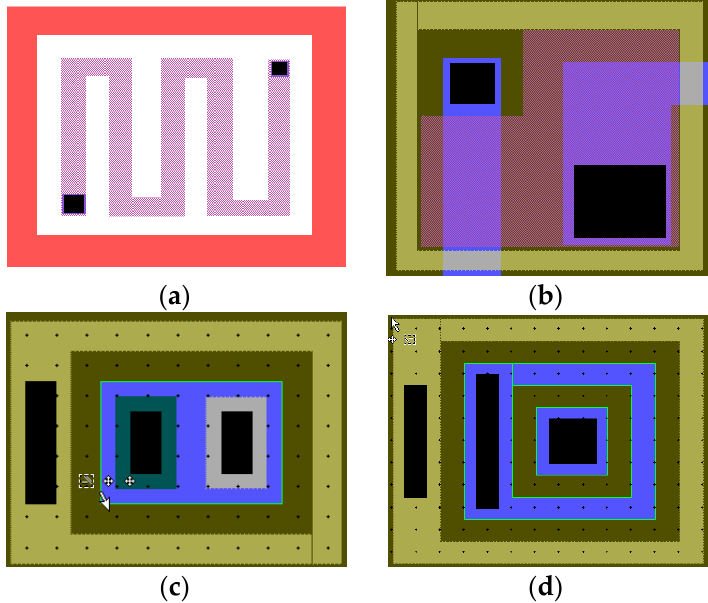
Figure 12. Layout of the basic component. ( a ) Resistor unit layout, ( b ) MOS (Metal Oxide Semiconductor) capacitor layout, ( c ) NPN (Negative Positive Negative) transistor layout, and ( d ) Substrate lateral PNP transistor layout.